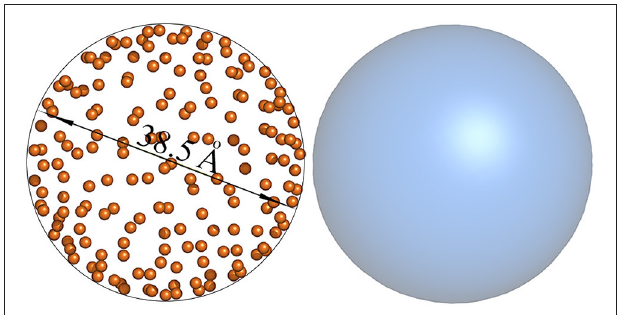
FIGURE 4 | Simulated three dimensional coordinates of the micelle in aqueous solution display sphere with diameter 38.5Å. (Left) dihexanoylphosphatidylcholine (DHPC phospholipids) are modeled as orange balls. (Right) Gaussian mapping at contour resolution 8Å of the micelle shows spherical